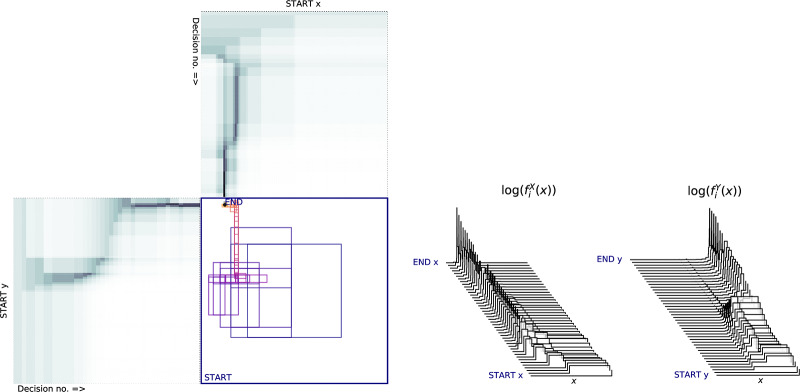
PDF evolution form a random run from C-15-15.(above) Colormap showing PDF after each input; darker indicates greater density (below) Ridge-plot of the same density sequence, where the height of the line is proportional to the log PDF; each line corresponds to a single decision. The maintenance of multiple hypotheses is visible.